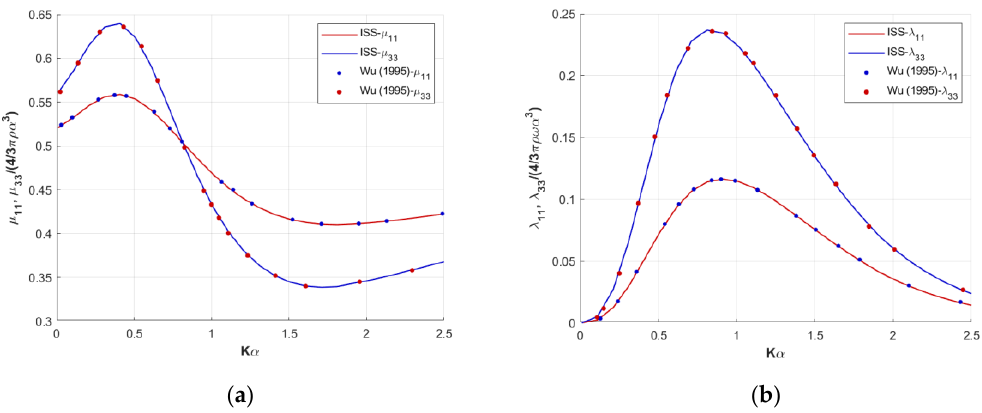
Figure 2. Normalized hydrodynamic coefficients for a sphere ( 𝑎 → 𝑏 in the case of ISS) immersed at 𝑓 = 1.5𝑎 : ( a ) Surge and heave added mass; ( b ) Surge and heave hydrodynamic damping.